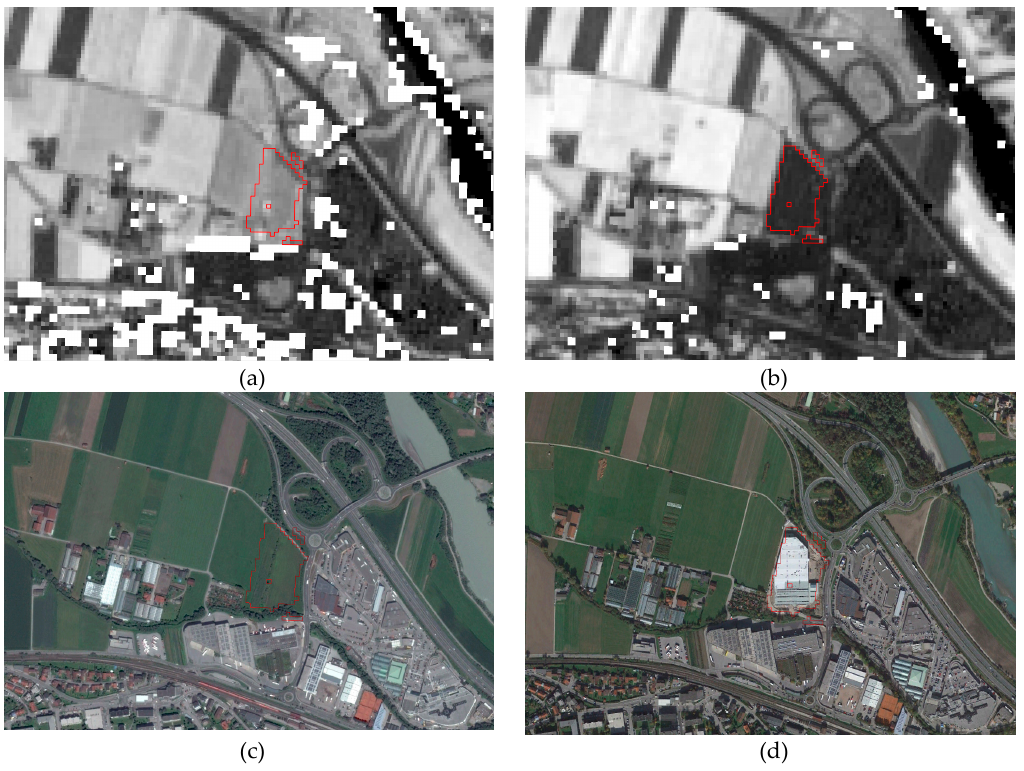
Figure 4. Sentinel 2 Normalized Difference Vegetation Index (NDVI) images (10m) showing the situation ( a ) before (2016/12/08) and ( b ) after (2017/02/25) construction began. Google Earth imagery of the same sites as ( a ) and ( b ) to show the change in ( c ) 2016/08/08 and ( d ) 2017/10/17.